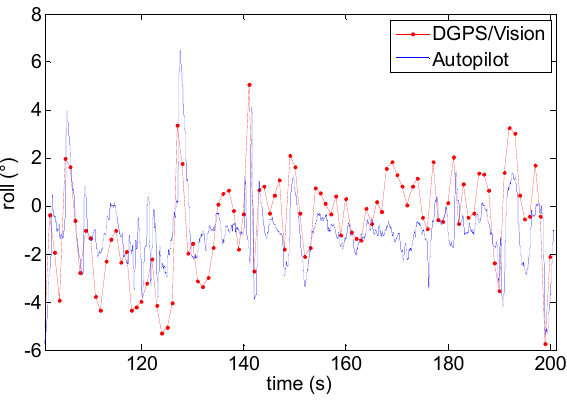
Figure 21. Heading angle as a function of time ( Top ), differences of DGPS/Vision with respect to autopilot and magnetometers ( Bottom ) during the second flight segment (Test 2). Table 4. Heading comparison (mean values in degrees).